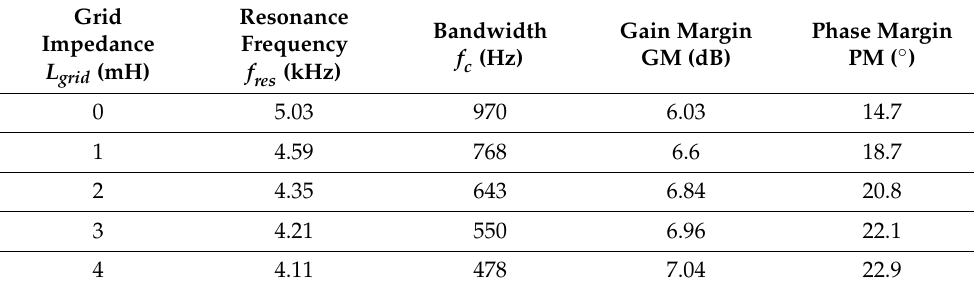
Figure 6. Loop gain Bode plots for the LCL filter type GcI with single-loop PI control under L grid variation ( a ) Using Bode Plots; ( b ) Using Root loci. Table 3. Stability analysis of single-loop PI control for the LCL filter type GcI.